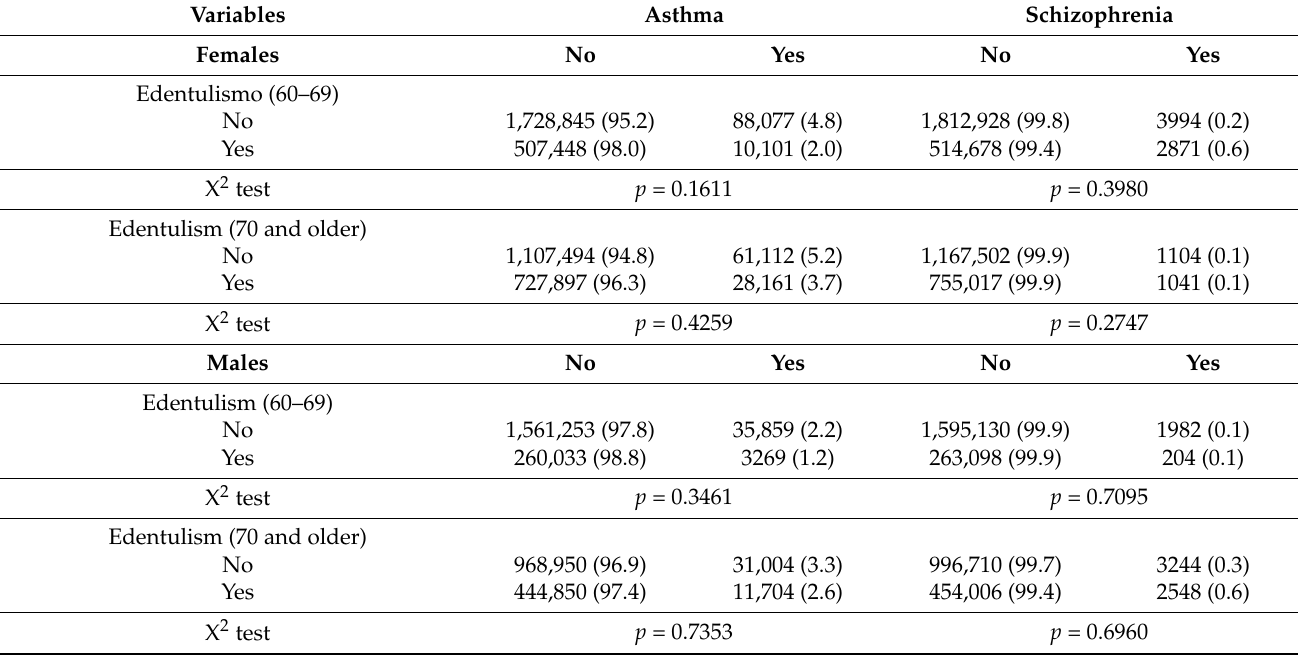
Table 5. Distribution of edentulism due to asthma and schizophrenia stratified by age group and sex (estimated population N =